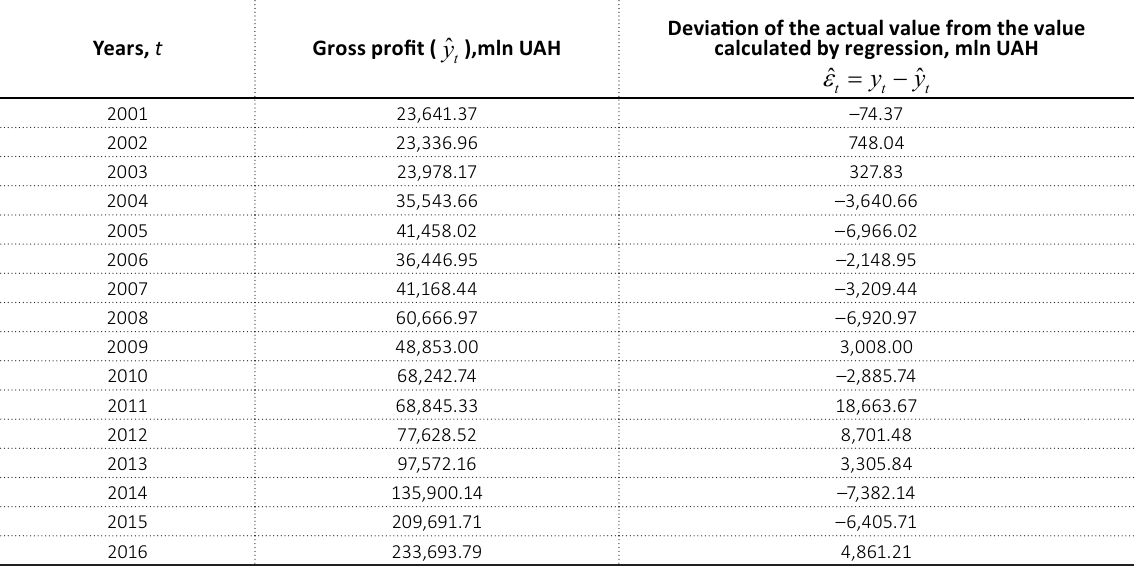
Table 4. Calculation of the gross profit in the agricultural sector of Ukraine and the accuracy indexes of the